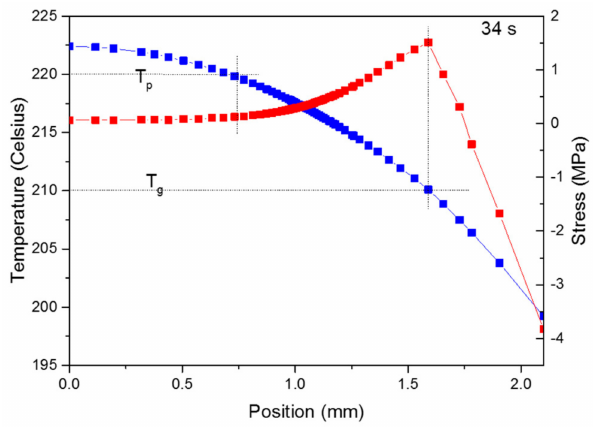
Figure A2. Knee point in stress curve corresponds to T g , and point where stress begins to develop corresponds to T p